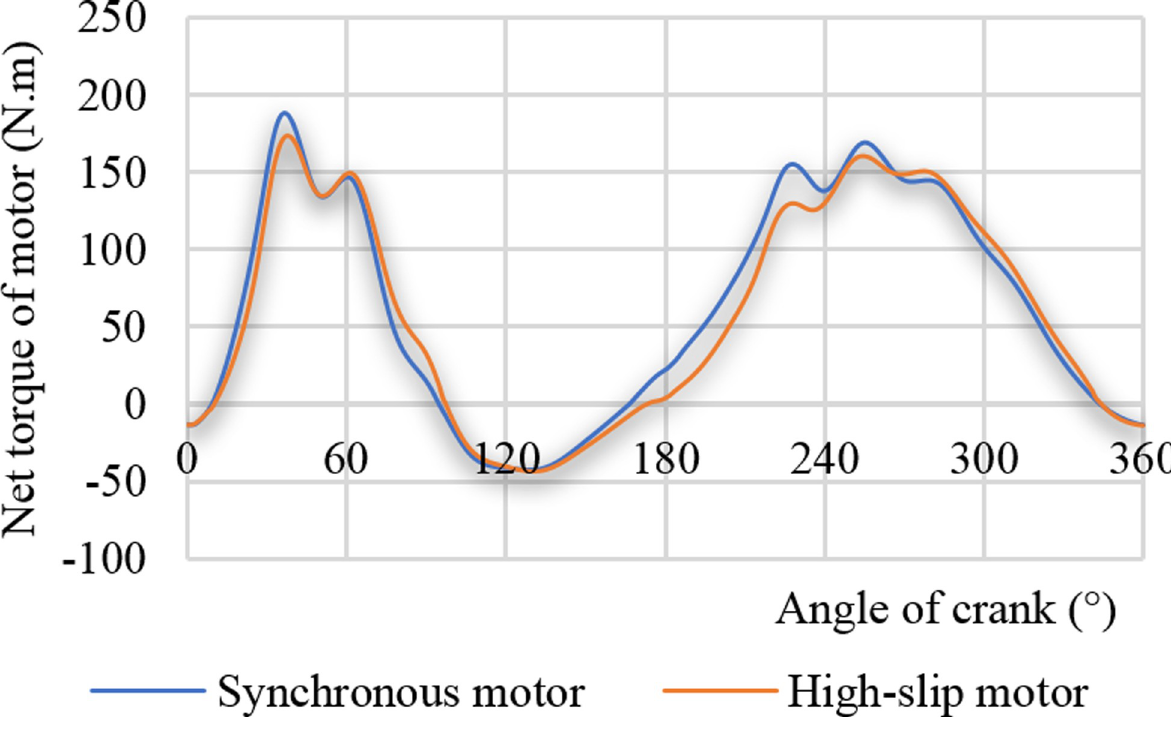
Fig 11. Net torque curves of motor.